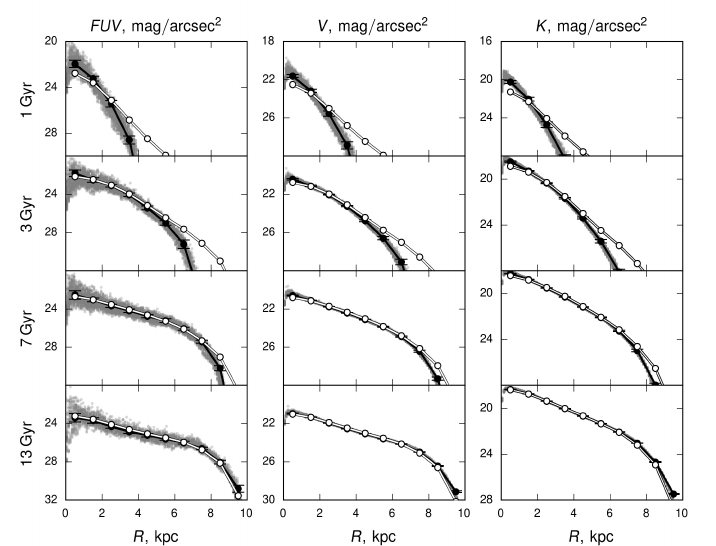
Fig. 9. The same as in Fig. 5, but for the surface brightness in the GALEX FUV , V and K passbands.